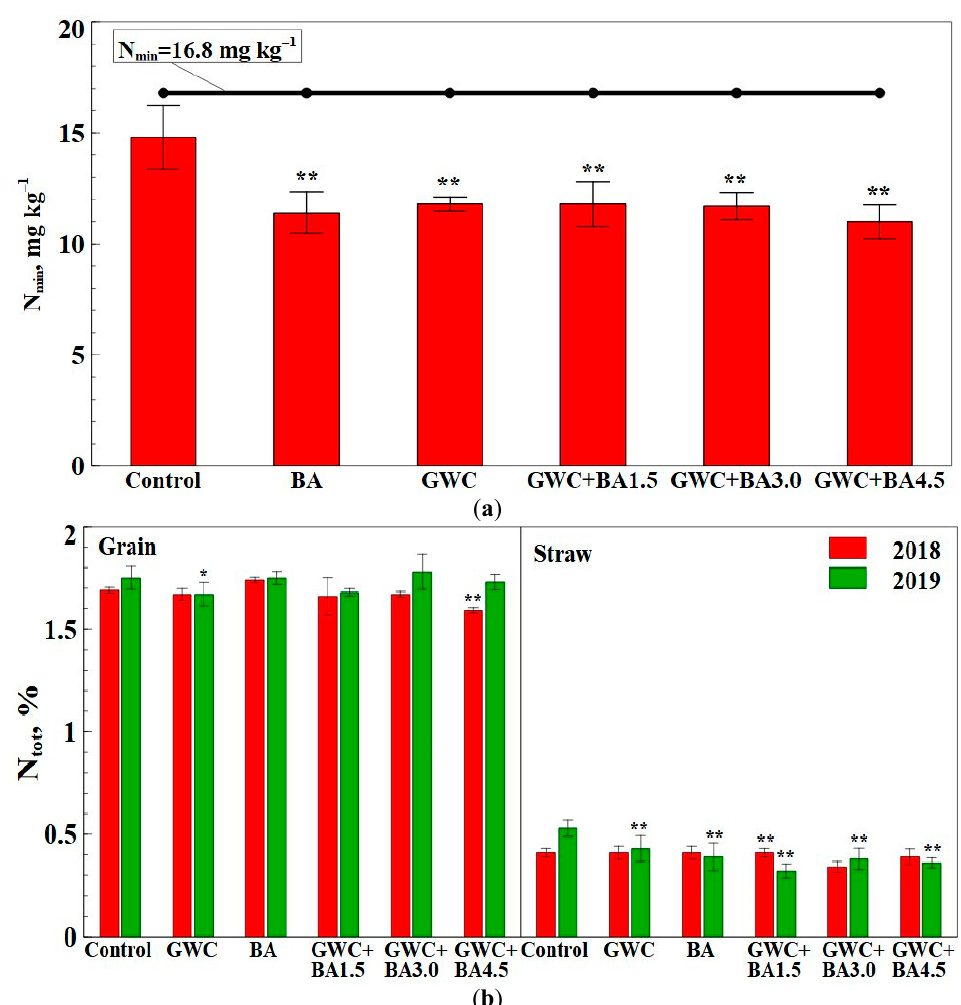
Figure 4. ( a ) N min in the soil before and after the experiment. N min before the experiment is shown with a solid line. ( b ) N tot concentration in spring wheat (2018) and spring triticale (2019) grain and straw. * = significance at p ≤ 0.05 and ** = significance at p < 0.01. BA—biofuel ash; GWC—green waste compost; GWC + BA1.5—green waste compost (20 t ha − 1 ) + biofuel ash (1.5 t ha − 1 ); GWC + BA3.0—green waste compost (20 t ha − 1 ) + biofuel ash (3.0 t ha − 1 ); GWC + BA4.5—green waste compost (20 t ha − 1 ) + biofuel ash (4.5 t ha − 1 ).